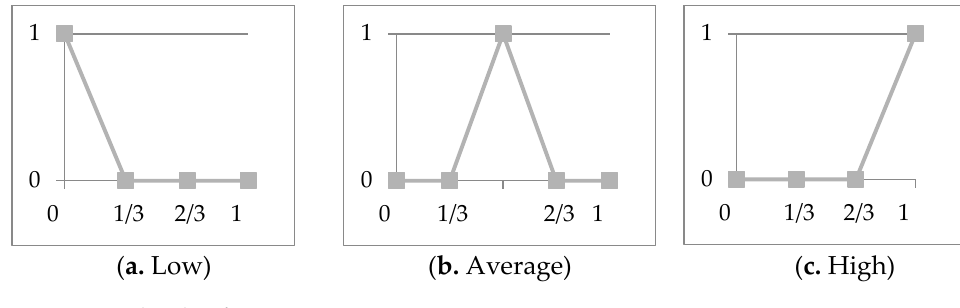
Figure 1. Membership functions.